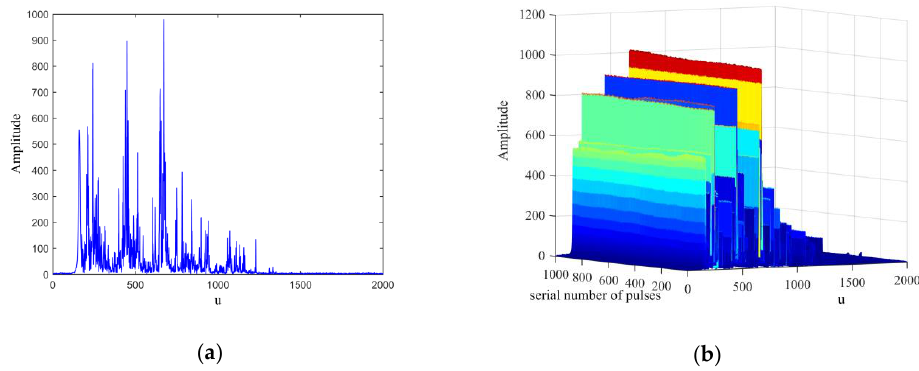
Figure 5. Fractional Fourier transform (FRFT) results of measured echoes with pulse repetition interval T pri = 200 µ s and sampling frequency f s = 10 MHz ( a ) FRFT of a single echo; ( b ) FRFT of 1024 continuous echoes.